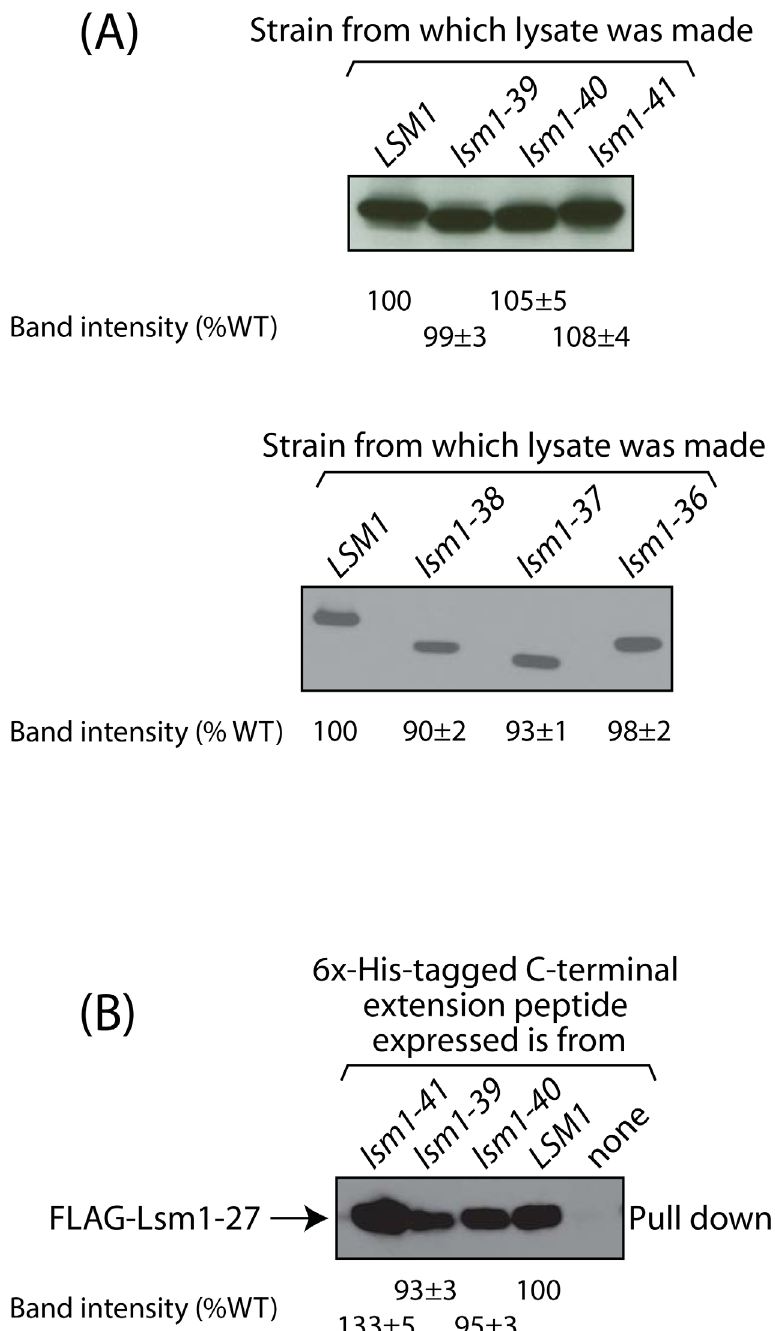
Fig 4. A , In lsm1-36 through lsm1-41 mutants the corresponding mutant Lsm1 proteins accumulate at levels comparable to that of wild type Lsm1 in wild type cells. LSM1 and lsm1-36 through lsm1-41 cells were grown to log phase and lysates were made from the cells. Equivalent amounts of lysates of LSM1 and lsm1-39 through lsm1-41 cells (upper panel) or LSM1 and lsm1-36 through lsm1-38 cells (lower panel) were subjected to western analysis using anti-FLAG antibodies. B , Co-precipitation of FLAG-Lsm1-27 with the C-terminal extension peptide is not significantly impaired by the lsm1-39 , lsm1-40 or lsm1-41 mutations in the peptide. Proteins pulled down from the lysates of FLAG-lsm1-27 cells over expressing His-tagged C-terminal extension peptides that are wild type or are carrying the lsm1-39 , lsm1-40 or lsm1-41 mutations were subjected to Western analysis using anti-FLAG antibodies. Band intensities quantitated using ImageJ software and normalized to the wild type value are given directly below the lanes of the western blots both in panels A and B .